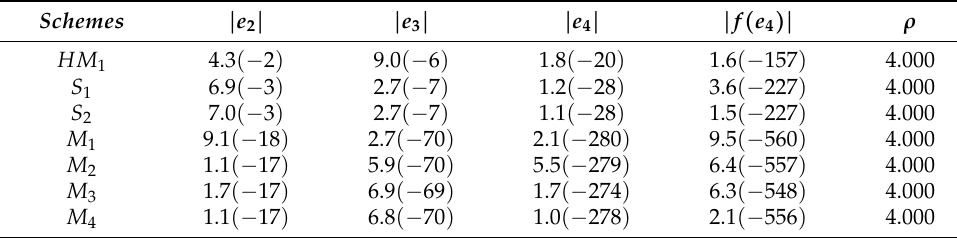
Table 4. Numerical results of function f 4 .